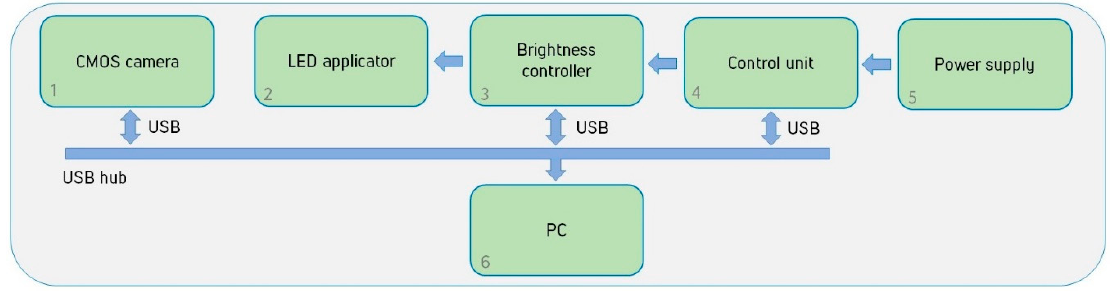
Figure 10. The block scheme of a modernized experimental setup.